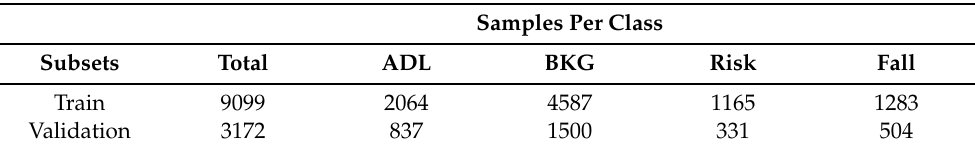
Table 7. Dataset distribution for each subset with best labelling thresholds.